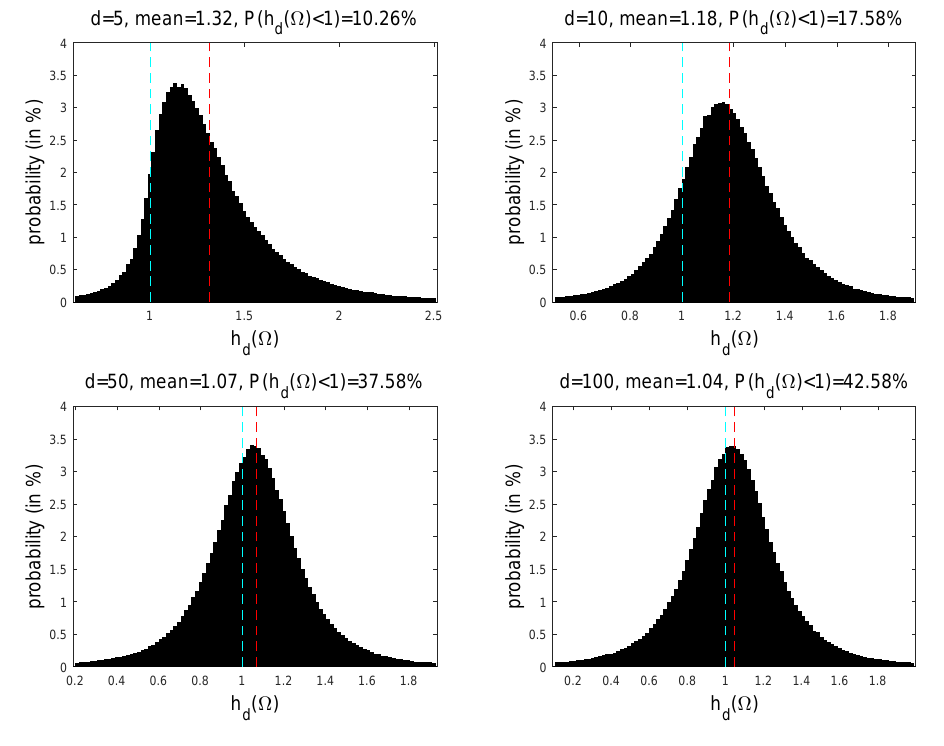
Figure 4: Histogram of the probability distribution of h d ( Ω ) with Ω ∼ U ( C d ) based on n = 1, 000, 000 simulations, for d ∈ { 5, 10, 50, 100 } . The vertical, red line gives the mean, and the blue line represents the border 1 between over- and un- derrepresentation of the non-central